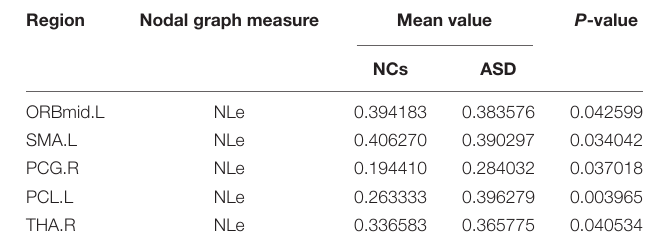
TABLE 7 | Between-group comparison in NLe. Region